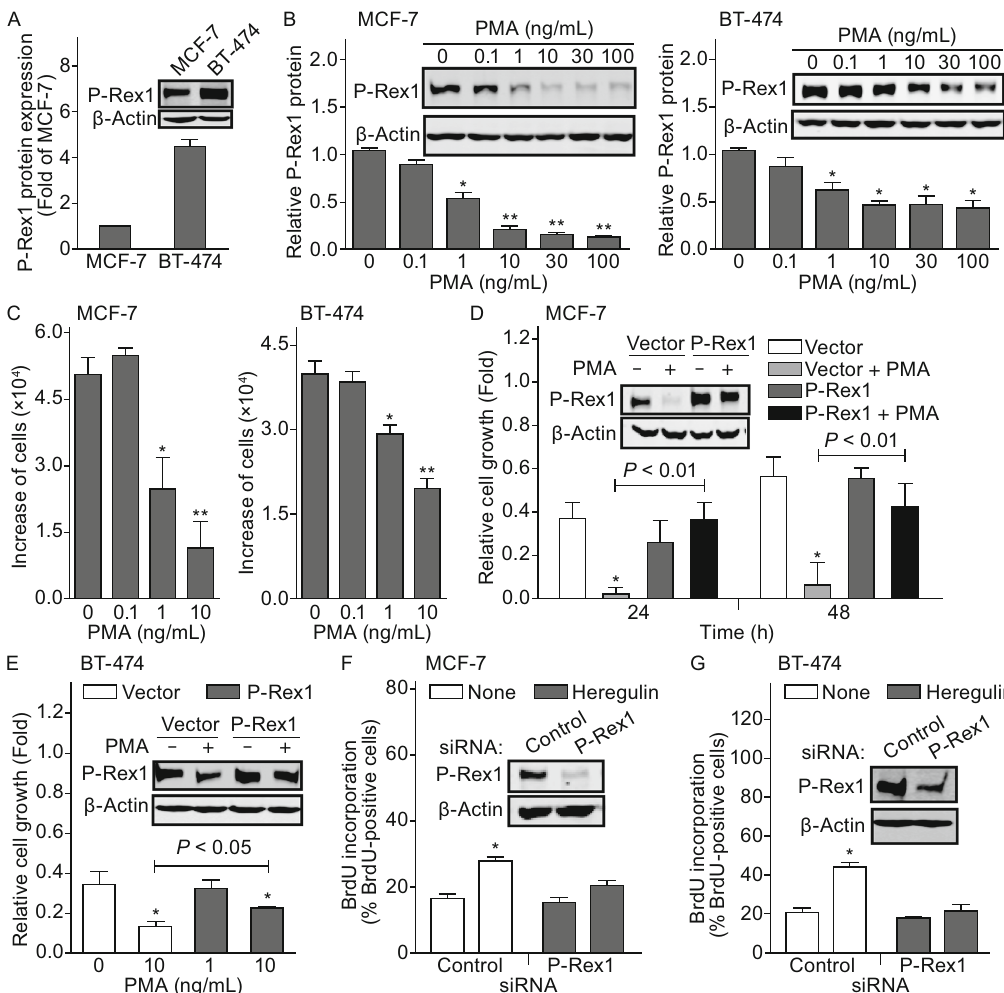
Figure 1. PMA suppresses breast cancer cell growth through P-Rex1 down-regulation . (A) Western blot analysis of P-Rex1 protein expression in MCF-7 and BT-474 cells. Data shown are means ± SEM ( n = 3). (B) PMA concentration-dependent down- regulation of P-Rex1 protein expression in MCF-7 and BT-474 cells. Data are means ± SEM ( n = 3) with * P < 0.01 and ** P < 0.001 compared with untreated cells, normalized by β -actin. (C) PMA concentration-dependent suppression of MCF-7 and BT-474 cell growth. Cells were cultured in the presence or absence of PMA for 48 h (MCF-7) or 72 h (BT-474). Data shown are means ± SEM ( n = 5 of duplicates) with * P < 0.05 and ** P < 0.001 as compared with untreated cells. (D and E) Expression of recombinant P-Rex1 blocked PMA inhibition of MCF-7 and BT-474 cell growth. Cells transfected with control vector or P-Rex1 were cultured in the absence or presence of PMA (10 ng/mL) for 24 h and 48 h (MCF-7) or 48 h (BT-474). Relative cell growth refers to increased cell number normalized by cell number prior to PMA treatment. Data are means ± SEM ( n = 5 of duplicates) with * P < 0.01 as compared to cells without PMA treatment. (F and G) Silence of endogenous P-Rex1 by its siRNA abolished heregulin (100 ng/mL)-stimulated MCF-7 and BT-474 cell proliferation, determined by BrdU incorporation assay. Data are means ± SEM ( n = 3 of triplicates) with * P < 0.01. Insets: Western blot analysis of P-Rex1 and β -actin protein expression in MCF-7 and BT-474